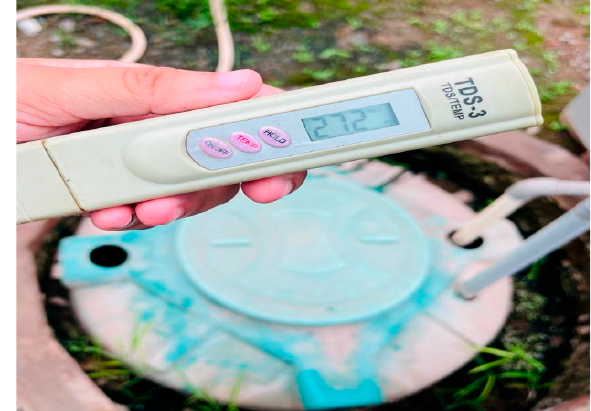
Figure 5. TDS measure in the solution used for the NFT.